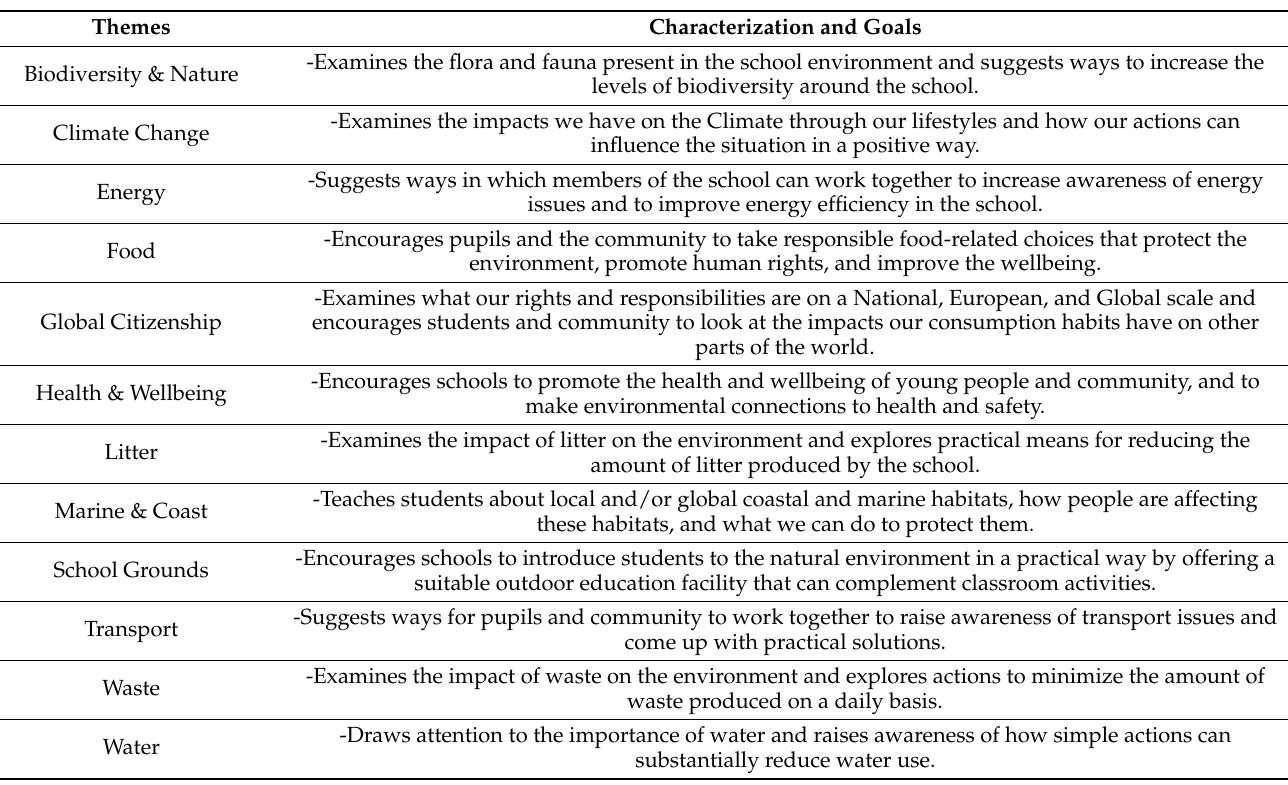
Table 2. Themes/Areas of Action on the Eco-Schools